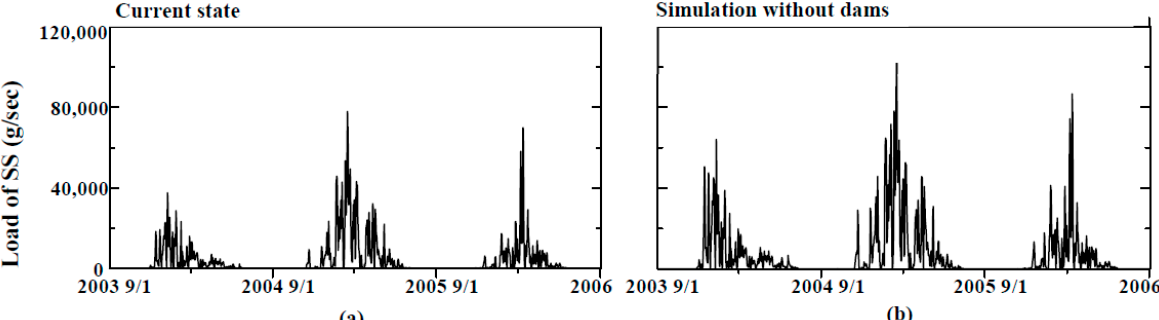
Figure 24. The flux of SS outflowing from the lake to the lagoon: ( a ) the simulation of the current state ( b ) the simulation without the dams.